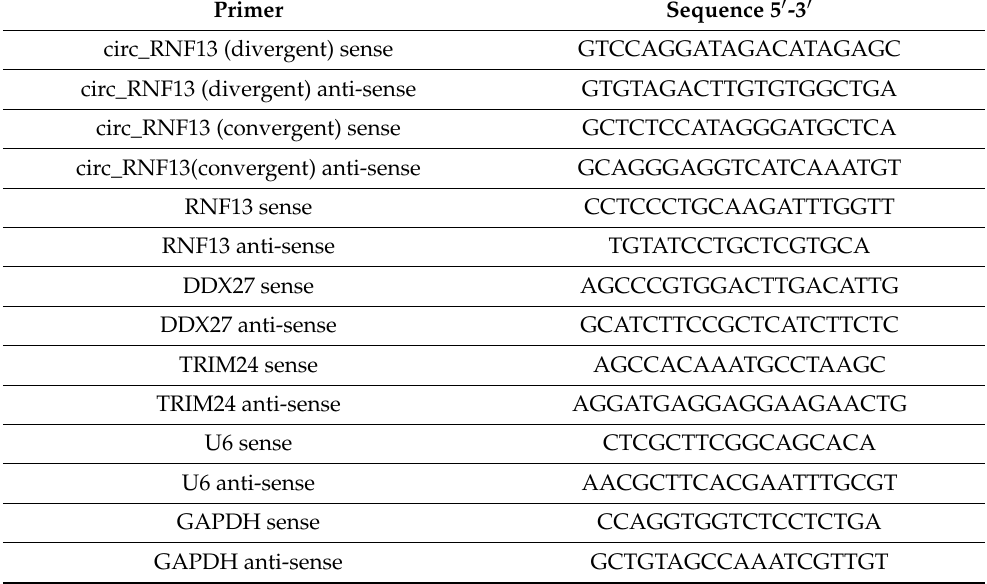
Table 1. The primers used in the